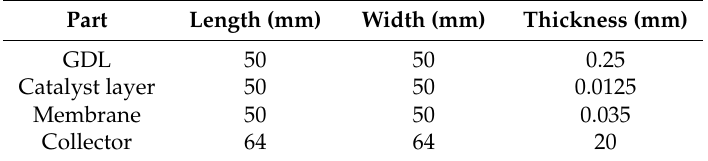
Table 2. Geometric details of the cell components used in this simulation [1,26–28]. GDL: gas diffusion layer.